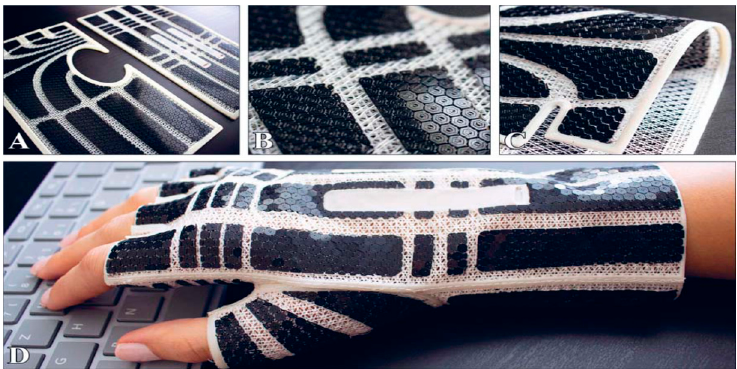
Figure 17. The drape dress and joint recovery supports/covers [93,100].